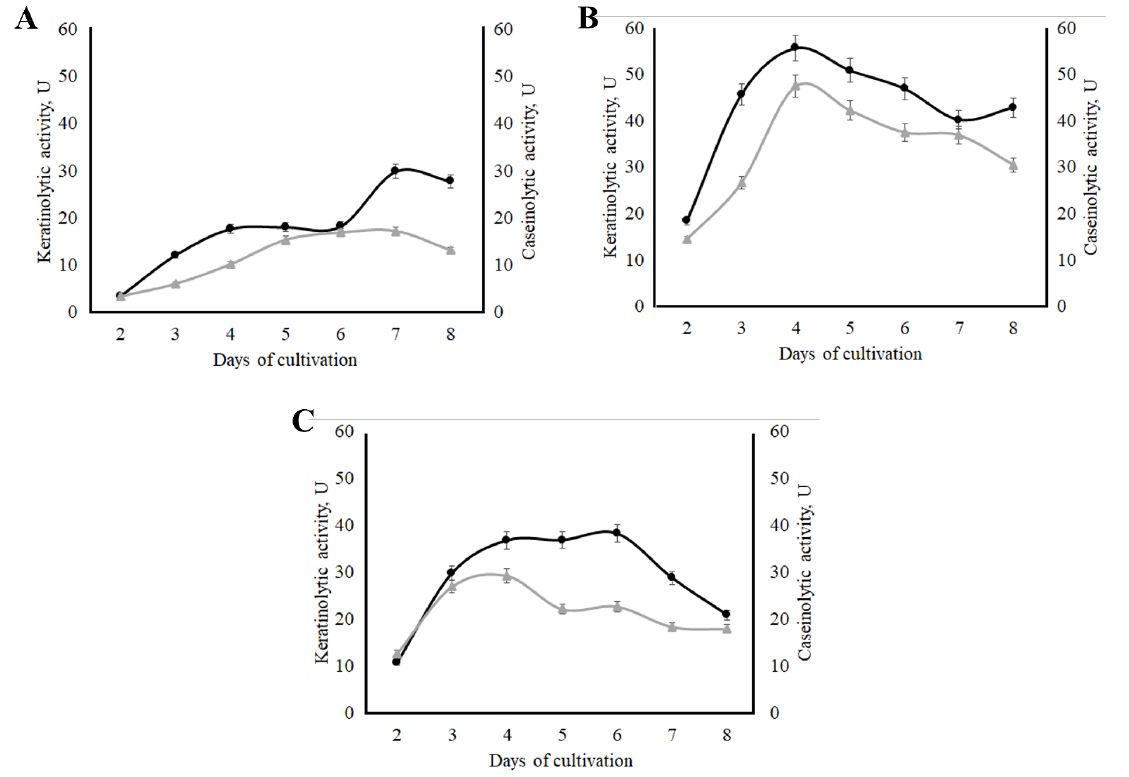
Figure 4. Accumulation of extracellular proteases synthesized by A. clavatus VKPM F-1593 during growth on the various media: ( A ) medium 4; ( B ) medium 5; ( C ) medium 6. Black lines — keratinolytic activity; grey lines — caseinolytic activity.